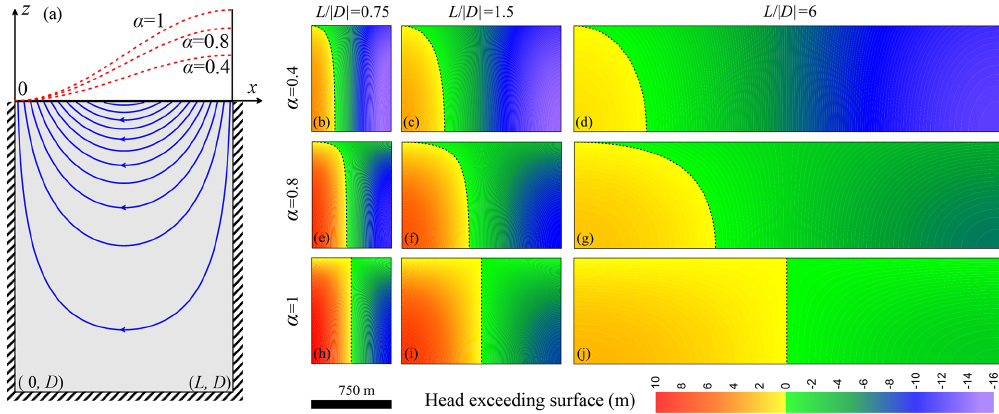
Figure 8. (a) The geometry of a unit basin with a length of L , depth of | D | and three scenarios of water table undulations (corresponding to different α ); (b–j) the distribution of head exceeding surface in the unit basin under three different water table undulations and basin length-to-width ratios ( L/ | D | ) (modified from Wang et al.,